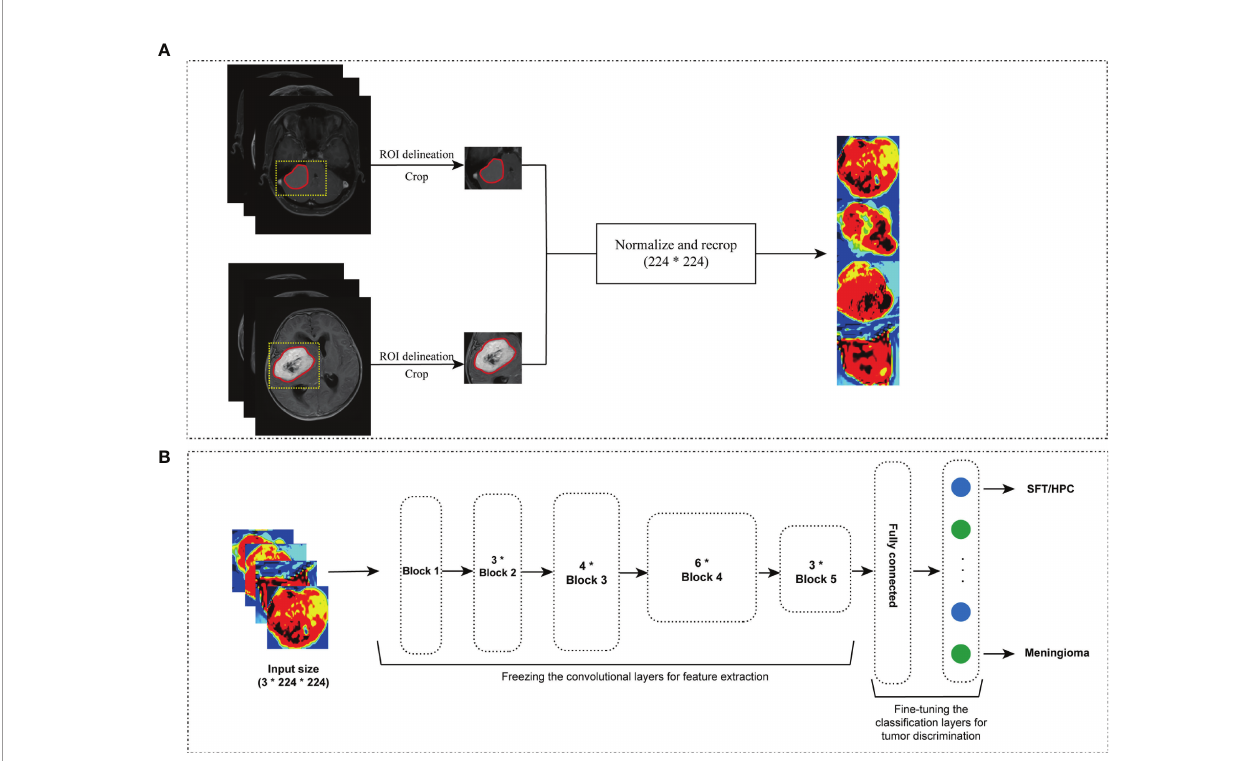
FIGURE 2 | Image preprocessing and model training. Regions of interest (ROIs) were extracted from the aligned images, and the jet colormap was applied to grayscale MRI images, followed by the use of 5 image augmentation techniques (A) . After preprocessing, input image size was reshaped to 3 × 224 × 224. ResNet- 50 convolutional layers were frozen, and the last classi fi cation layers were retrained for solitary fi brous tumor/hemangiopericytoma (SFT/HPC) and meningioma discrimination (B)